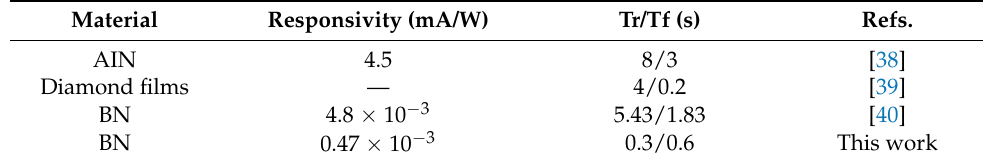
Table 1. Parameter comparison of VUV